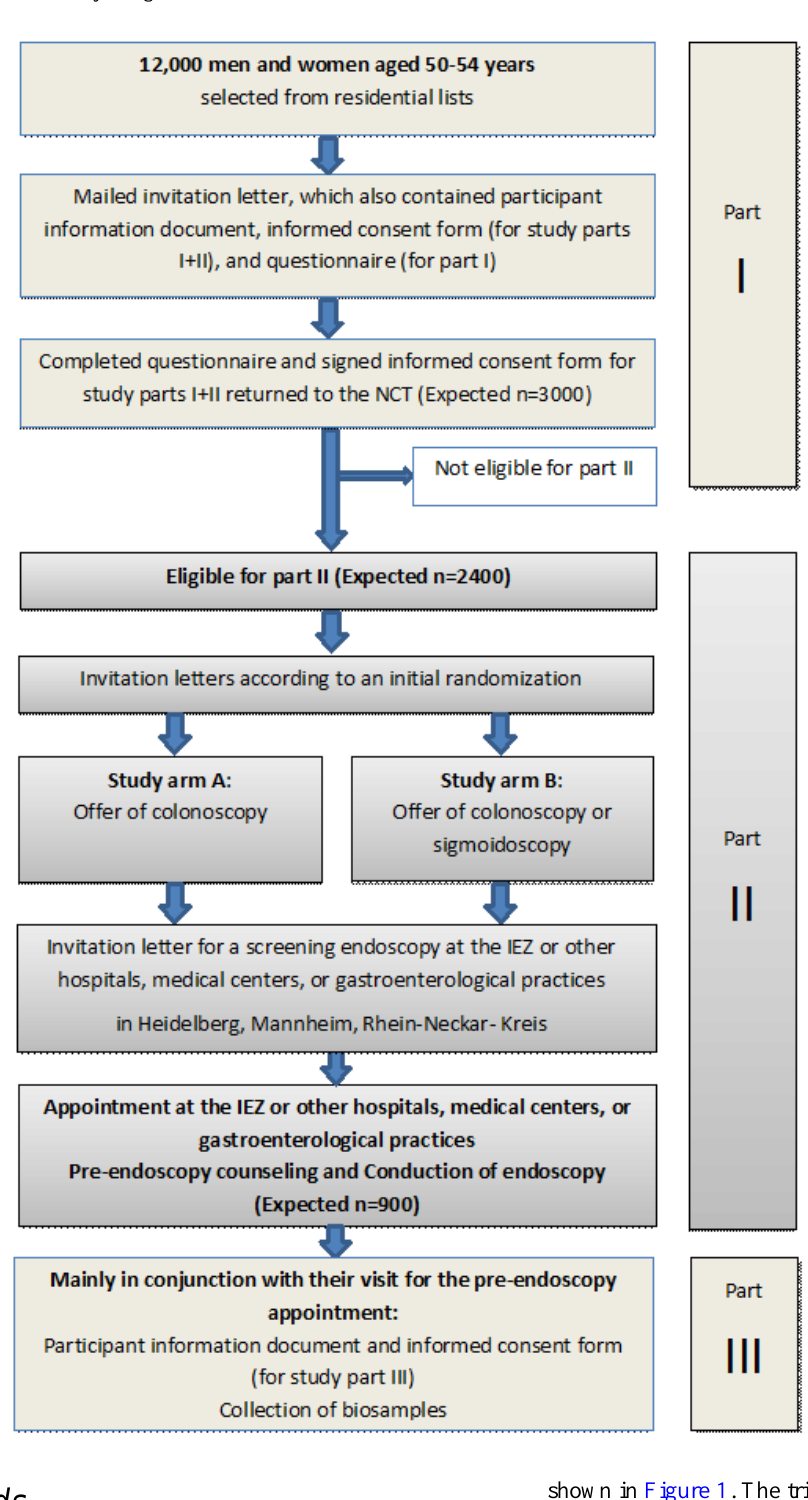
Figure 1. DARIO study